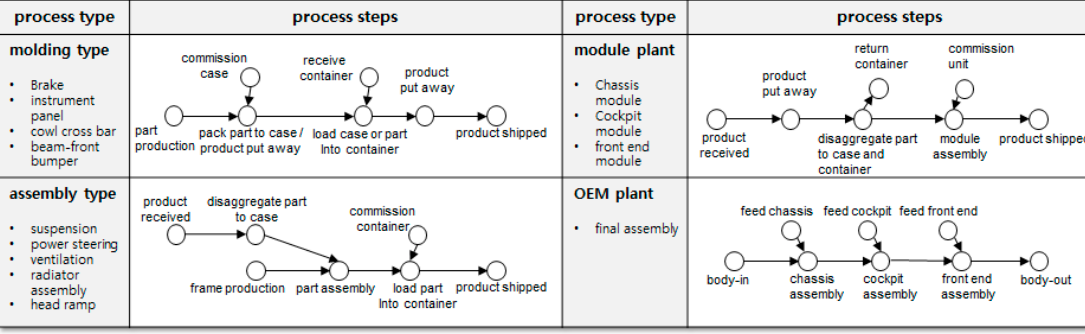
Figure 10. Internal processes according to manufacturing type.